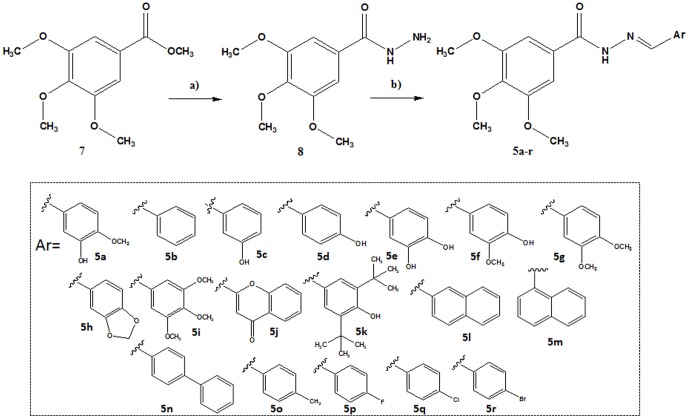
Conditions and reagents: a) 80% aq. N2H4.H2O, EtOH, reflux, 2 h, 93%.
b) ArCHO, EtOH, HCl (cat), r.t., 0.5–4 h, 62–95%.